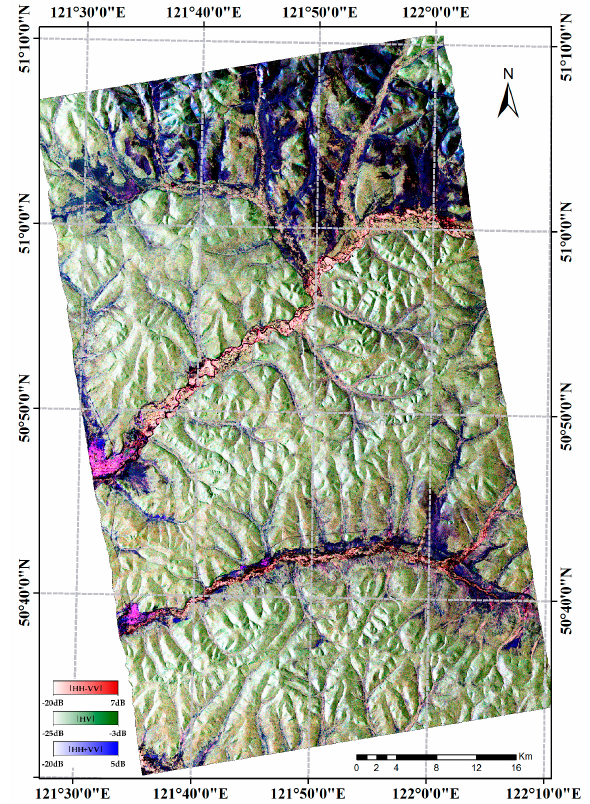
Figure 9. The Pauli RGB after GTC.